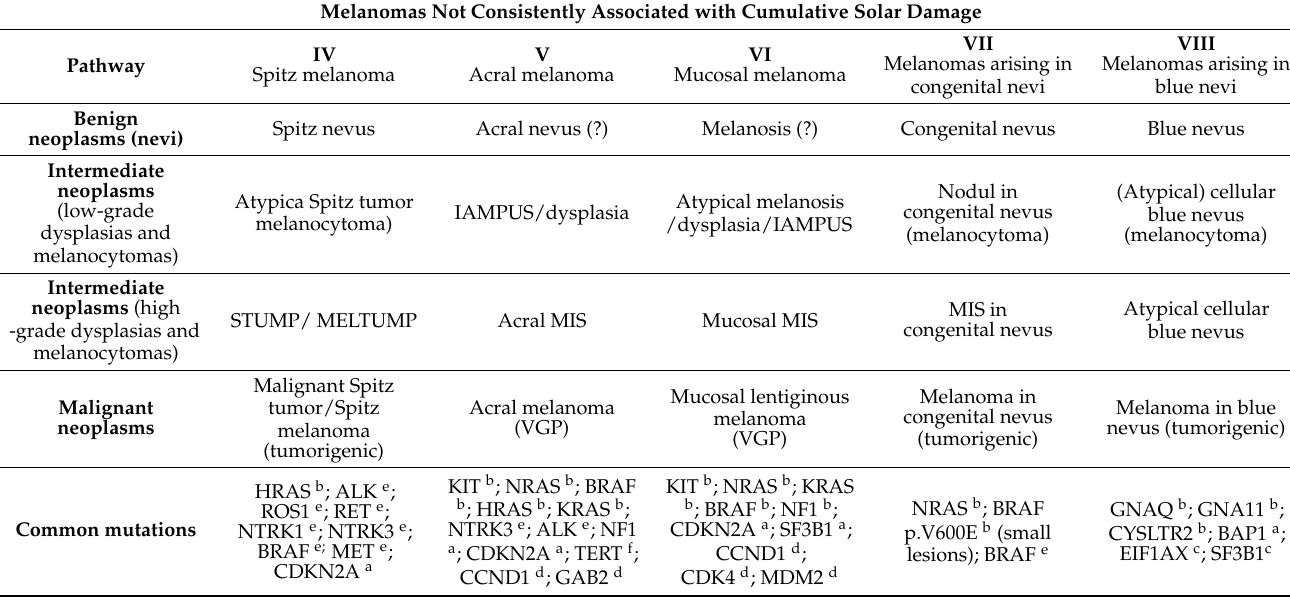
Table 3. Pathways for melanomas that are not consistently associated with cumulative solar